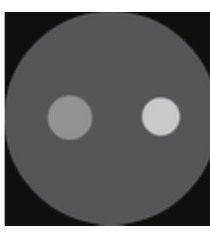
Figure 5: Model of prior image.